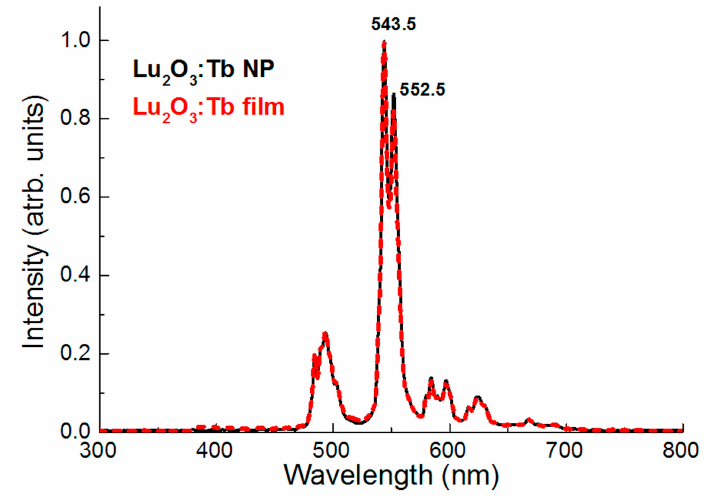
Figure 8. RT CL spectra of Lu 2 O 3 :Tb NP and film.